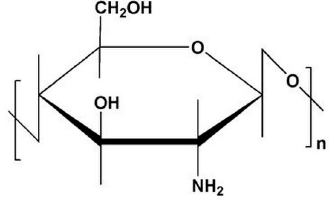
Figure 1. Chemical structure of chitosan (CS).